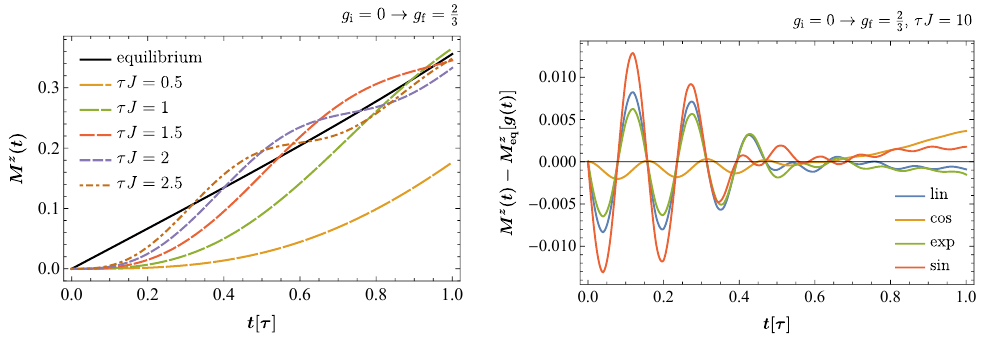
Figure 4: Transverse magnetisation during the quench for various quench durations (left) and protocols (right). Left: Linear quench from g value of transverse magnetisation for a given g ( t ) . Right: Deviation of the magnetisation in linear, cosine, sine and exponential quenches from the equilibrium magnetisation for the corresponding g ( t )